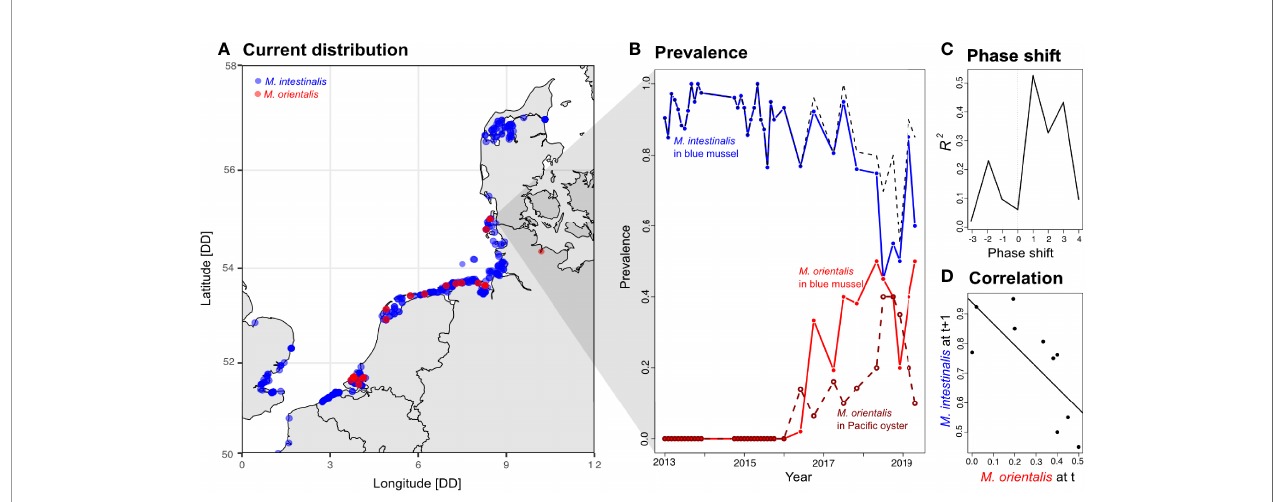
FIGURE 1 | (A) Current distribution of Mytilicola intestinalis (blue) and M. orientalis (red) in the North Sea. Each dot represents an occurrence report and darker dots show multiple observations from the same site. (B) Prevalence of M. intestinalis in mussels (blue lines) and M. orientalis in mussels (red line) and oysters (dark red line, open circles) in Königshafen, Sylt, Germany covering the years 2013-2019. The black dashed line shows the overall prevalence of both species in mussel hosts. (C) Phase shift analysis including the years 2016 to 2019 when both parasite species were present. Observed prevalence data of M. intestinalis was shifted forward and backward along the time axis to calculate correlation coef fi cients between the prevalence curves of both parasites at time shifts ranging from -3 to +4 steps. The best correlation between prevalences was obtained when M. orientalis prevalence from time point t was correlated with M. intestinalis prevalence from time point t+1. (D) The resulting negative correlation (estimate = -0.718 ± 0.241, t = -2.985, p = 0.018) suggests that M. orientalis is driving M. intestinalis out of its niche in the mussel